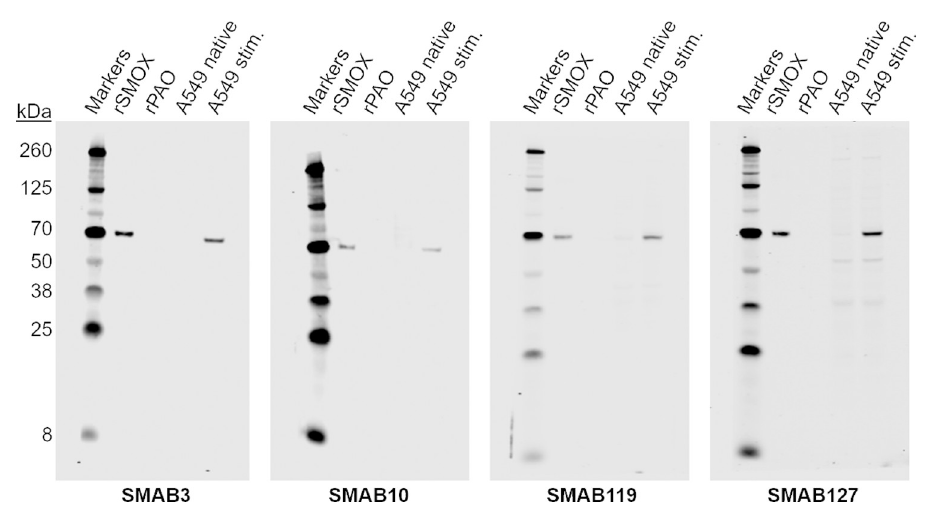
Fig 4. SMABs in Western blot. Application of selected SMABs in Western blot using control and BENSpm stimulated A549 cells. rhSMOX and rhPAOX were used as positive and negative controls, respectively. For the blots shown, rhSMOX bands were also visible for non-stimulated A549 cells upon increasing signal intensity (not shown). GAPDH was used as a loading control (see S4 Fig). Loading: 10 ug lysate, 1 ng rhSMOX, 1 ng rhPAOX.